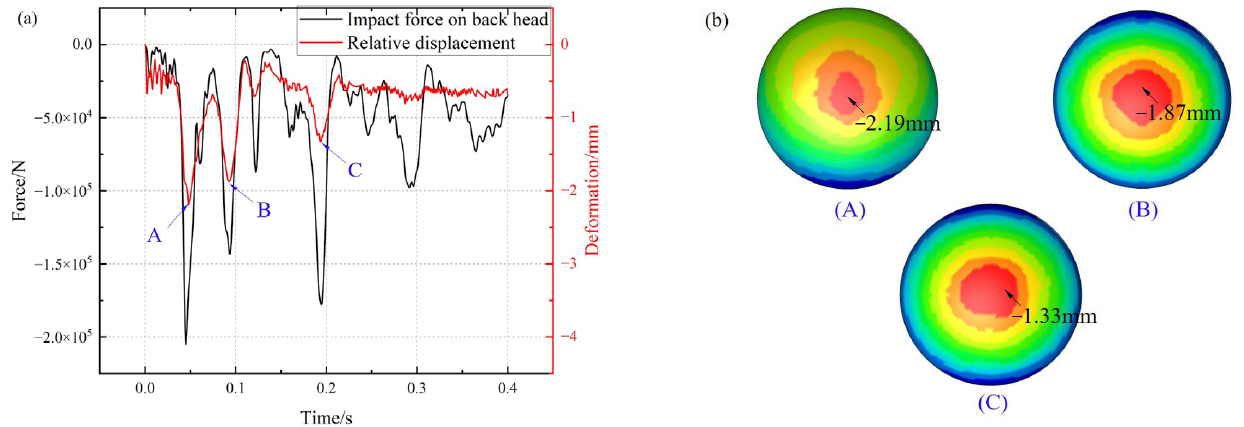
Figure 19. The variation of the back head maximum relative axial displacement over time: ( a ) relationship with the LNG impact force; ( b ) location of three peak displacements.